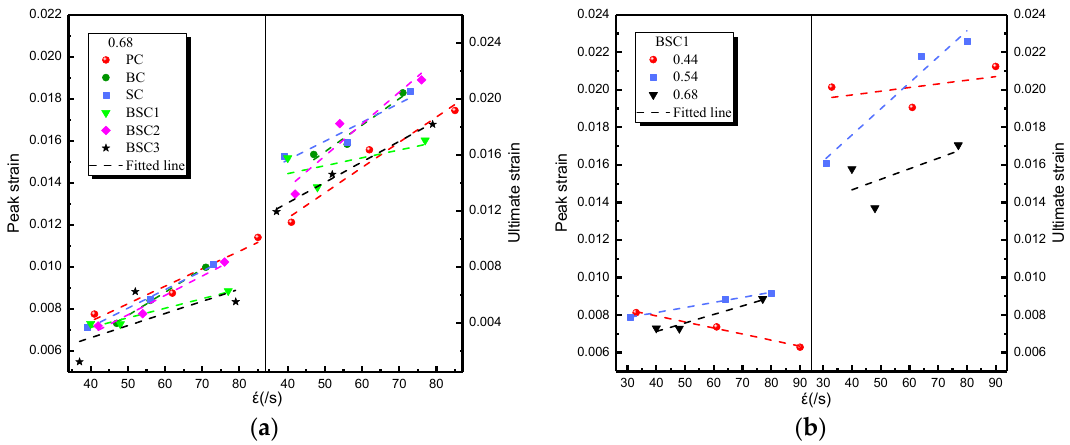
Figure 14. Strain rate effect on impact strain of BSFRC: ( a ) w/c ratio: 0.68; ( b ) BSC1.